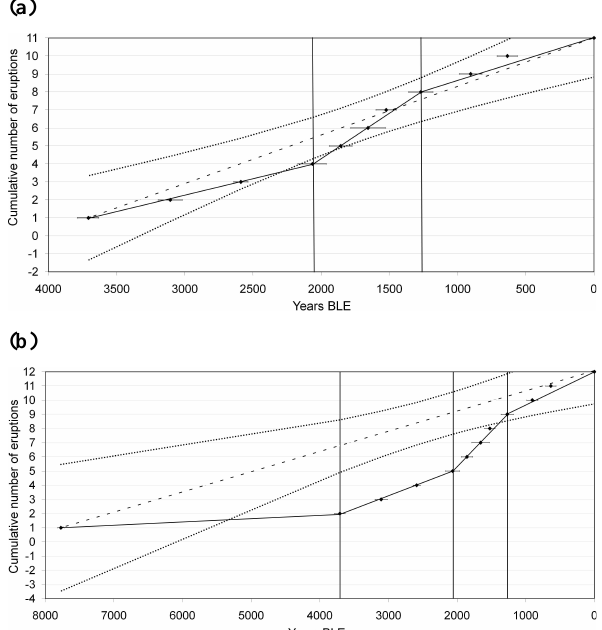
Fig. 1. Cumulative number of eruptions of El Chich´on volcano re- ported for the periods (a) 3707 and (b) 7772 years before of the last 1982 eruption in the magnitude class VEI ≥ 3, and the regimes that can be recognized. The slopes of the solid lines represent the eruption rates of each regime, the slope of the dashed line rep- resents the eruption rate of the whole series and the dotted lines are their 95% confidence bounds ( λ global =0.026976 eruptions per decade in 3707years BLE, and λ global =0.014153 eruptions per decade in 7772years BLE). The vertical lines mark the points of regime change.